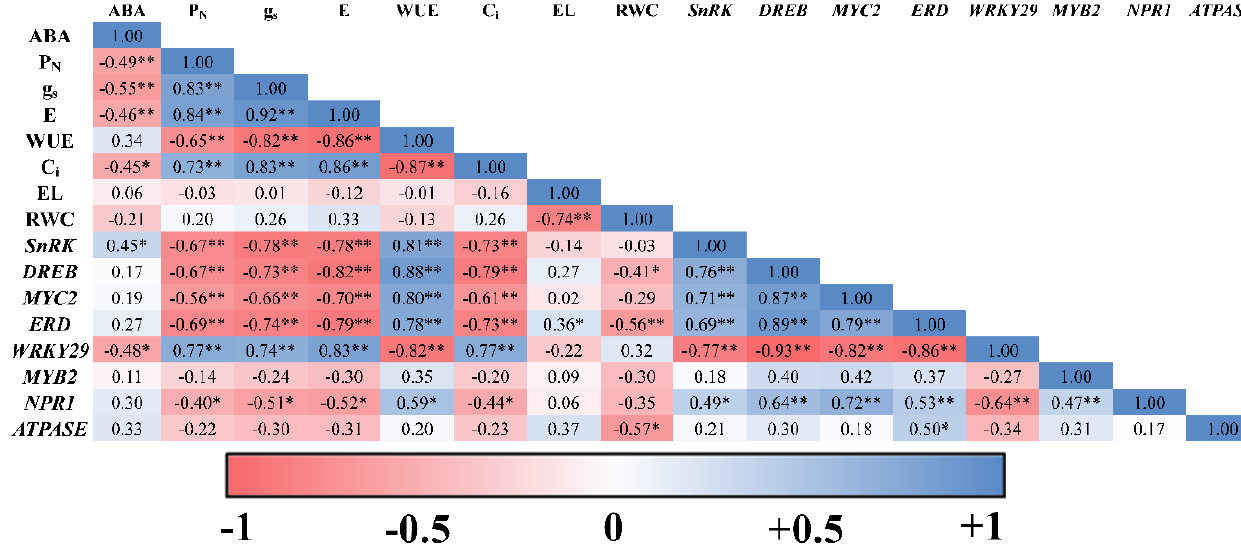
Figure 5. Correlation matrix to investigate the dependence between ABA concentration, physiological parameters (P N , g s , E, WUE, C i , EL and RWC) and transcript levels of ORGs ( SnRK , DREB , MYC2 , ERD , WRKY29 , MYB2 , NPR1 and ATPASE ) in all apple rootstocks after treatment with 30% PEG. The blue color indicates a positive correlation and the red color indicates a negative correlation. Asterisk(s) indicate(s) significant differences at * p < 0.05, ** p < 0.01 according to Pearson correlation test.